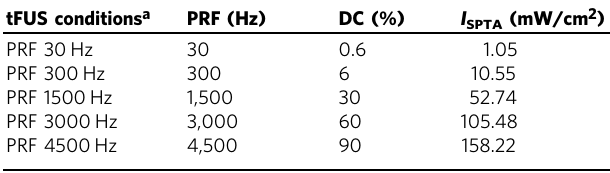
Table 1 Administered tFUS conditions with constant